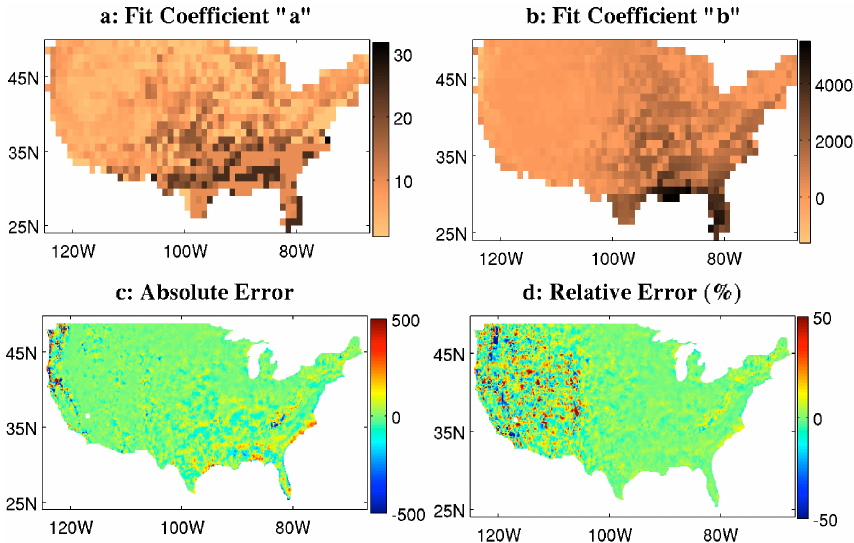
Figure 5. Evaluation of observational estimates of R . Method 2: erosivity calculated from annual modified Fournier index F , using the formula R = a · F + b (details in the text). (a) The multiplicative coefficient “ a ” in the above formula, calculated by regression on the grid- points in each 1 ◦ × 1 ◦ box (b) , as in (a) , but for the coefficient “ b ”. (c) Absolute error between the estimate of R in Fig. 3d and the target field in Fig. 3a. (d) Relative error in percent.